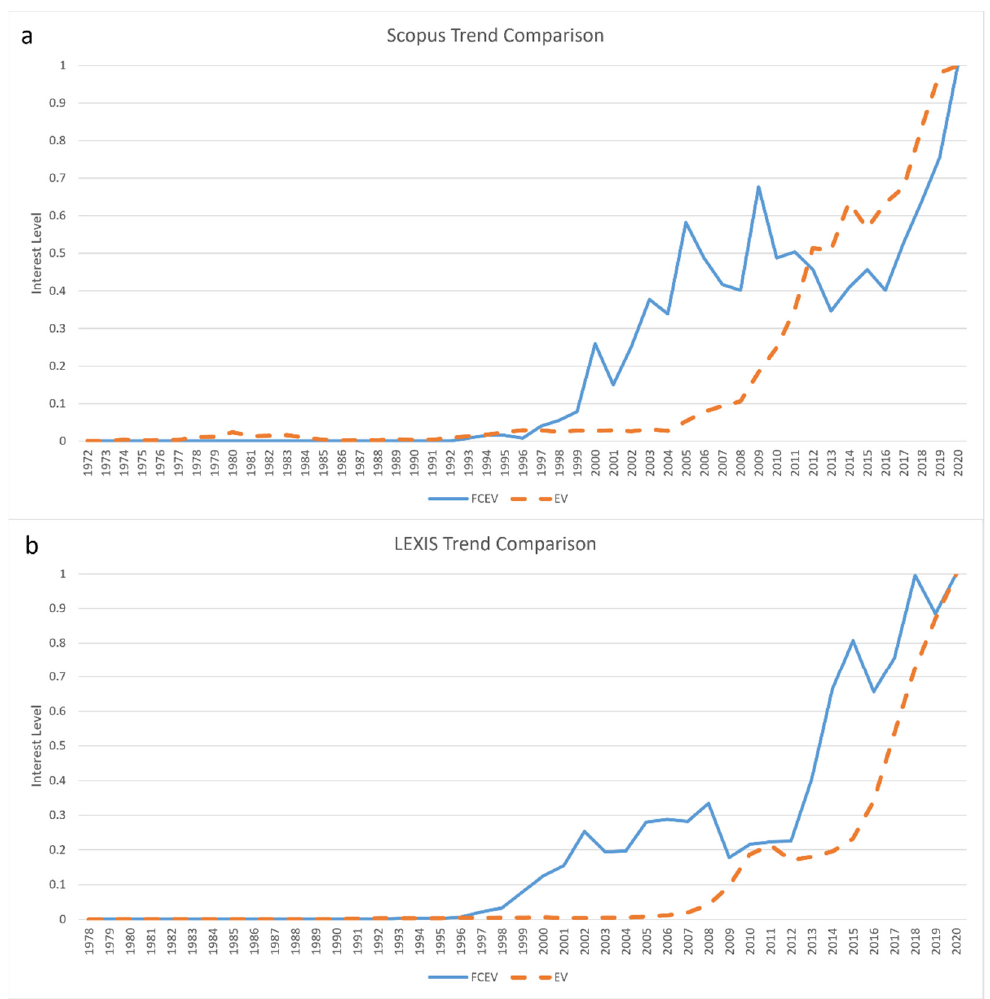
Figure 8. Trend Comparison between FCEV & EV ( a ) Normalized annual publications from SCOPUS ( b ) Normalized annual publications from LEXIS.